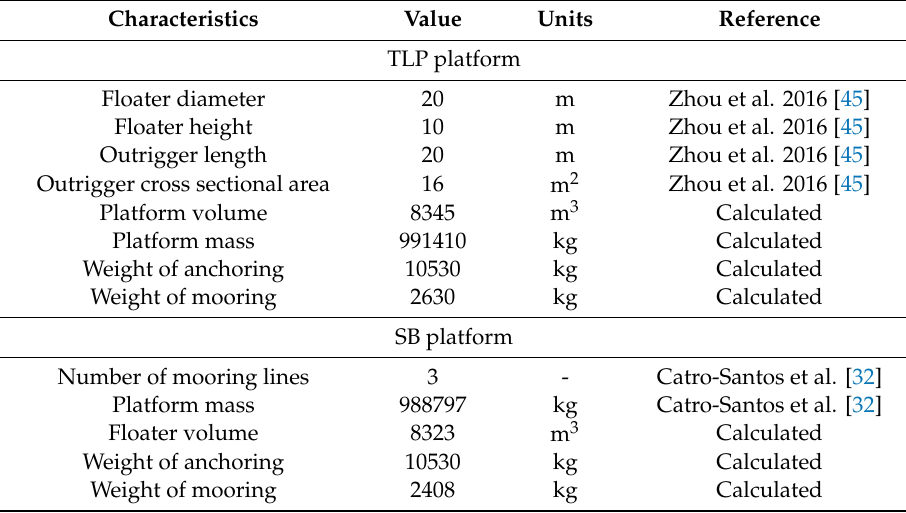
Table 2. Structural characteristics of Tension Leg Platform (TLP) and Spar Buoy (SB) platforms.